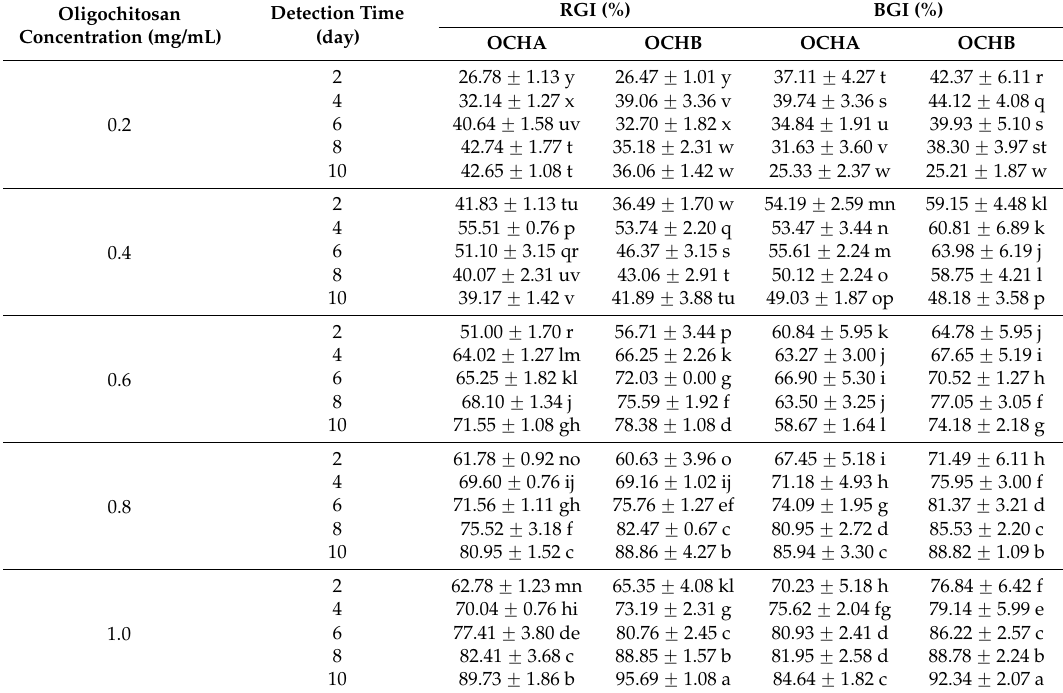
Table 1. Effects of oligochitosan A (OCHA) and oligochitosan B (OCHB) on the radial colony and biomass growth of F. sambucinum